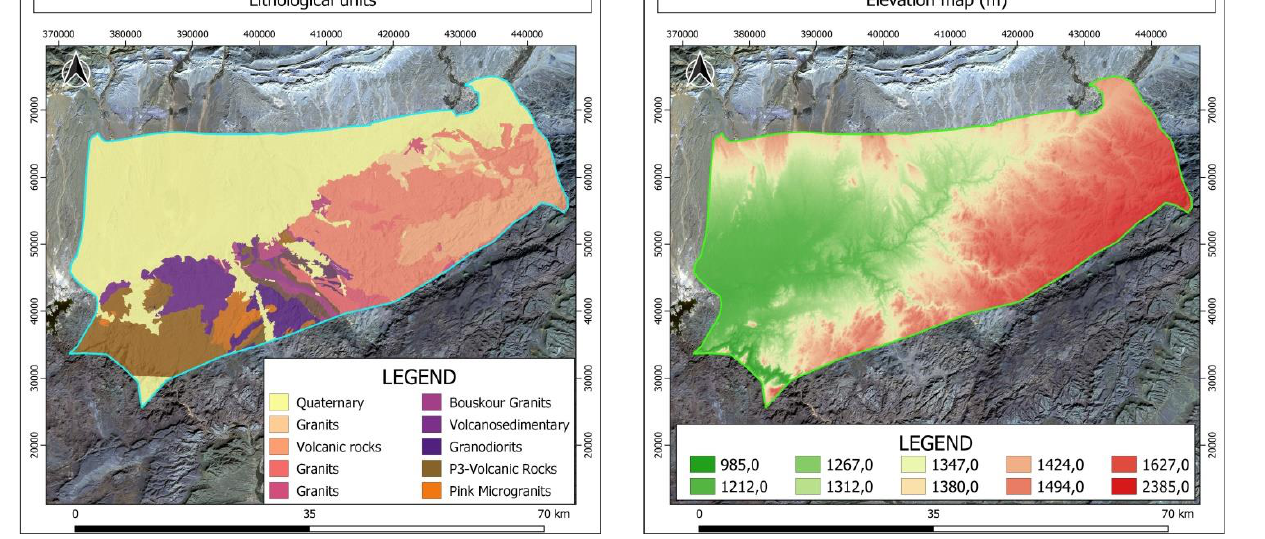
Figure 3: Lithological map of the study area. The lithological units at each pixel were used as the labelled data for the models.